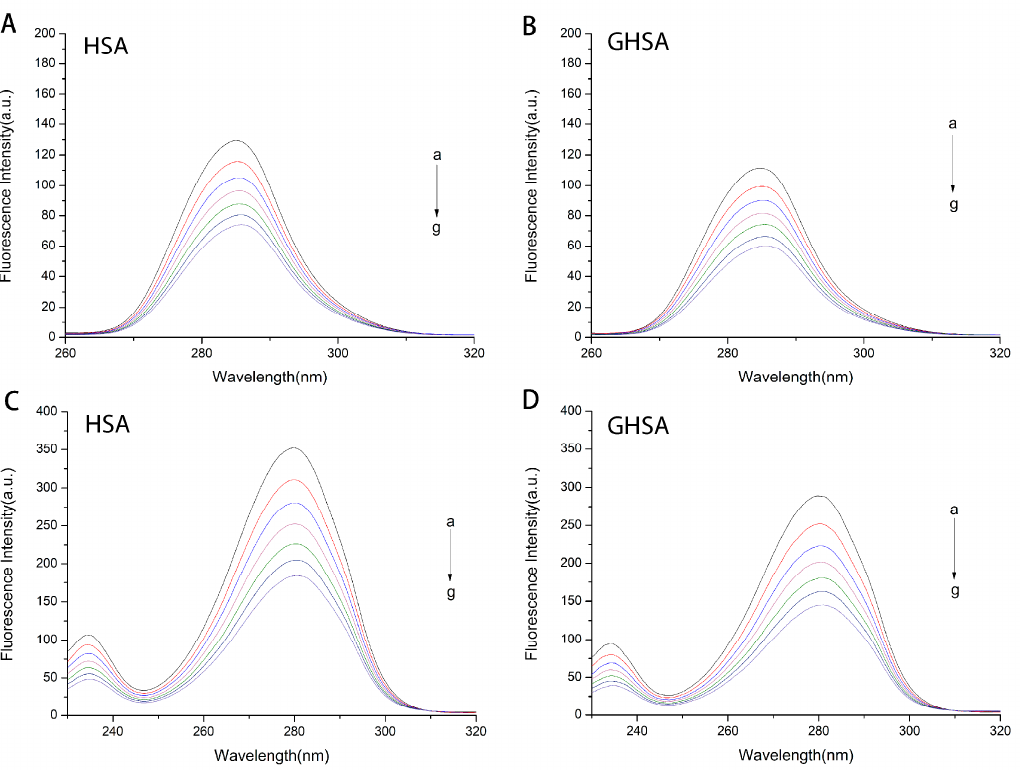
Figure 4. Synchronous fluorescence spectra of HSA and GHSA while varying the concentration of TF ( A – B : ∆ λ = 15 nm, C – D : ∆ λ = 60 nm). a–h: C HSA / C TF = C GHSA / C TF = 1:0, 1:1, 1:2, 1:3, 1:4, 1:5, 1:6